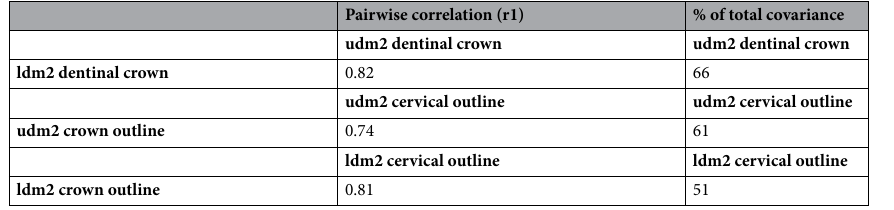
Table 3. Results of the 2B-PLS (single warp score 1) for the deciduous upper and lower second molars (udm2 and ldm2, respectively). The covariation between upper and lower dentinal crowns ( combined enamel- dentine junction and cervical outline), and between cervical and crown outline in both udm2s and ldm2s was calculated.